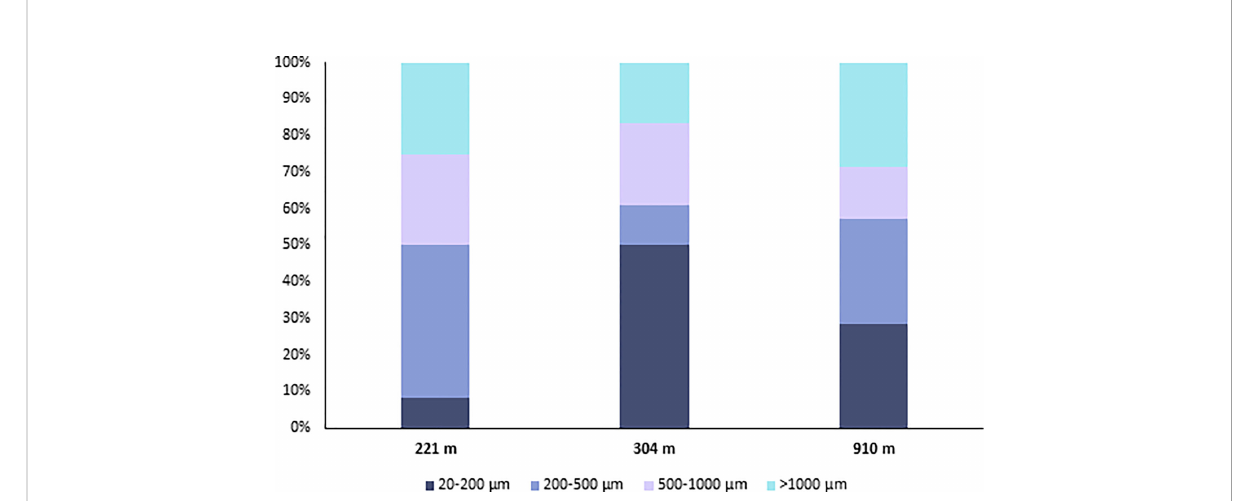
FIGURE 7 Partitioning of microplastics among the different size ranges in the deep-sea sediments of the San Gregorio